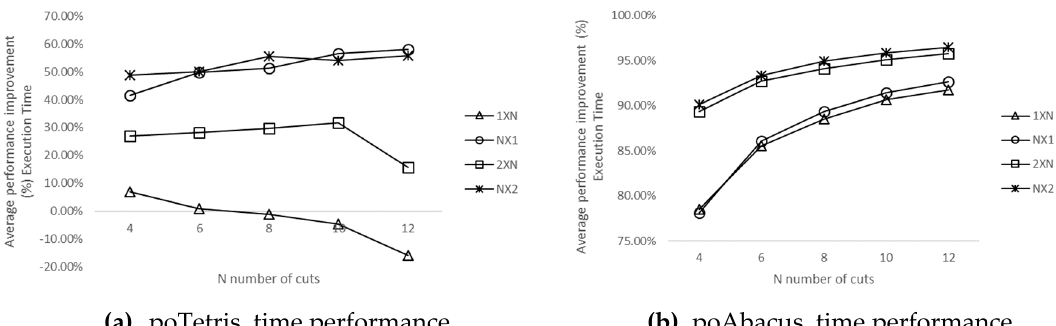
Figure 6. Time comparison for different partition alternatives.